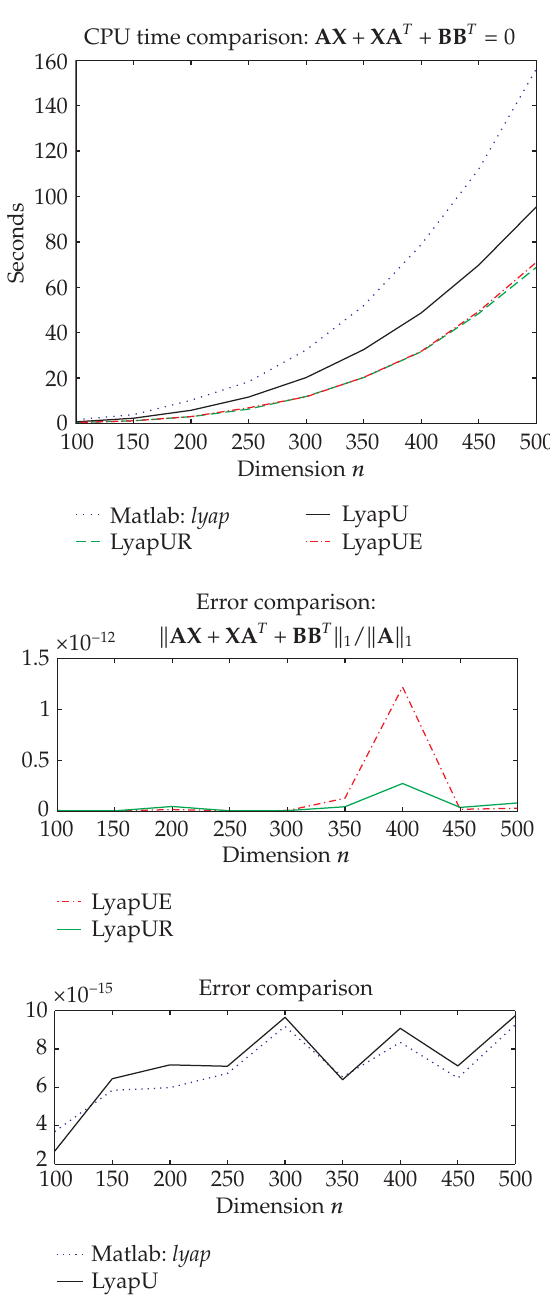
Figure 3.1 . Performance comparison for the Lyapunov solvers ( Matlab 6.0 )